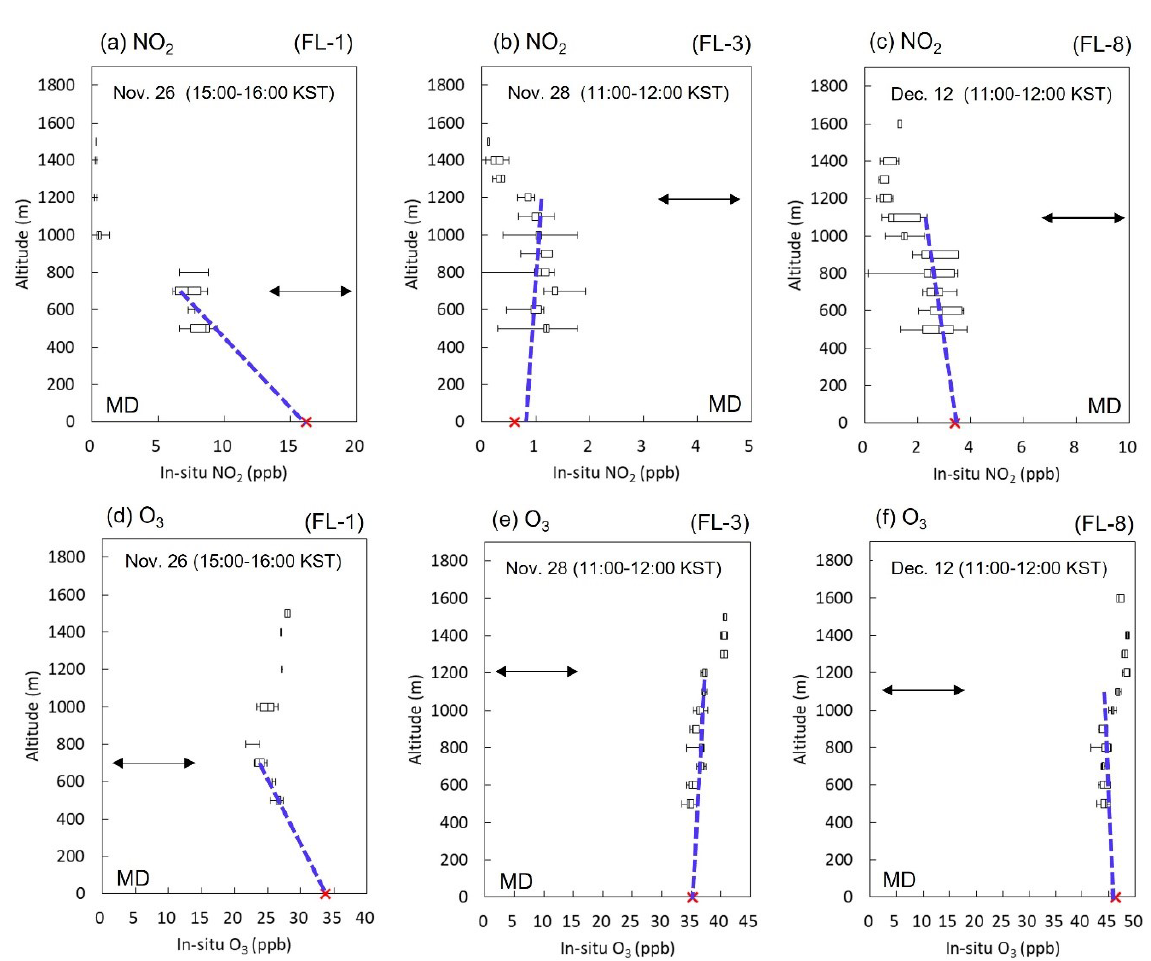
Figure 8. Box and whisker plots of vertical profiles obtained from GMAP aircraft superposed with in situ AQMS measurements for (1) NO 2 and (2) O 3 for flights (a) FL-1 (26 November), (b) FL-3 (28 November), and (c) FL-8 (12 December). Blue dashed lines are linear regres- sion lines fitted to NO 2 and O 3 in the PBL. Black arrows indicate PBLH simulated by the Hybrid Single-Particle Lagrangian Integrated Trajectory (HYSPLIT) Global Forecast System